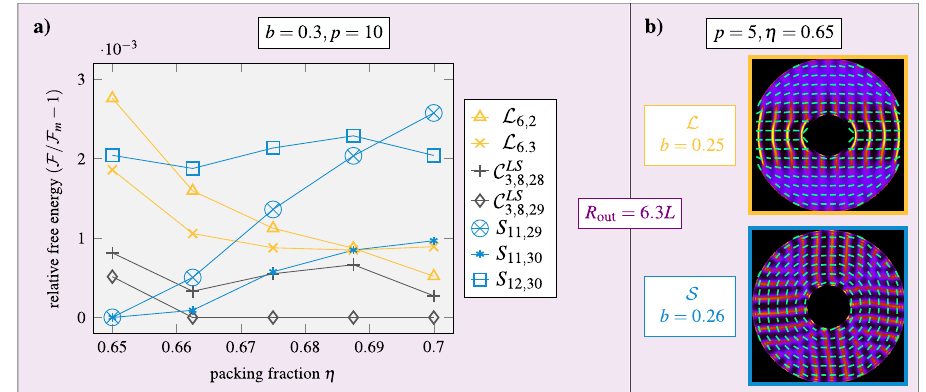
Fig. 7 Stable and metastable structures for different intrinsic parameters. The geometry is fi xed by R out = 6.3 L and b = 0.3. a Dependence of the relative free energy on the density. The data for area fraction η = 0.65 (at b = 0.3) and the estimated numerical error are the same as in Fig. 6. Here, alike symbols denote the structures obtained by gradually increasing the area fraction in steps of 0.0125. b Stable structures (as in Fig. 1d) for shorter rods with p = 5 with inclusion size ratios b = 0.25 and b = 0.26. The laminar-Shubnikov transition is thus located in between. Source data are provided as a Source Data